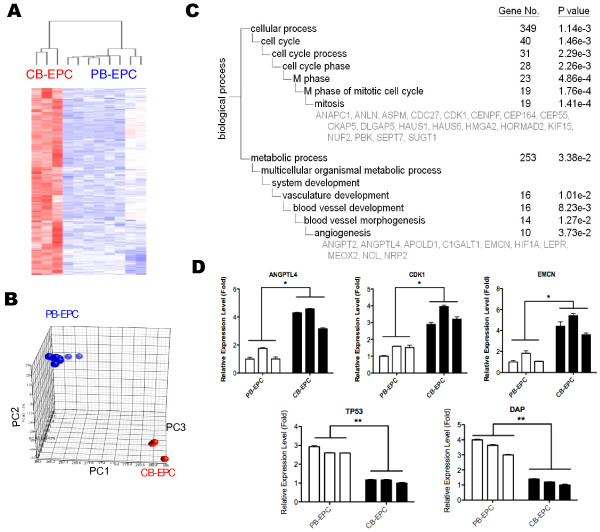
Distinct gene expression patterns of different EPCs. ( A) A heat map showing genes more abundant in CB-EPCs. Columns represent EPC samples from different donors, while rows represent probe sets. Genes in red: increased expression; in blue: decreased. ( B) A principle component analysis (PCA) plot using genes differentially expressed between different EPCs. Each spot represents a single array sample. ( C) The unique biological functions of CB-EPCs. CB-EPC-enriched genes were subjected to a Gene Ontology (GO) database search. These categories were selected from the “Biological Process” organizing principle in the GO database (http://www.geneontology.org/). The number of genes, gene symbols, and p values for each category that are significantly enriched are listed (p < 0.05). (D) Validation of mRNA array data by qPCR. Mean gene expression levels of EPC genes were compared to the average CT values of GAPDH and beta-actin controls. Results are expressed as mean ± standard deviation. *:P < 0.05 ( E) Canonical pathways enriched in CB-EPCs according to the analysis of the Ingenuity Pathway Analysis (IPA) web tool. ( F) Schematic representation of the “FLT3 Signaling in Hematopoietic Progenitor Cells” pathway. CB-EPC genes assigned to this pathway are indicated and in red.